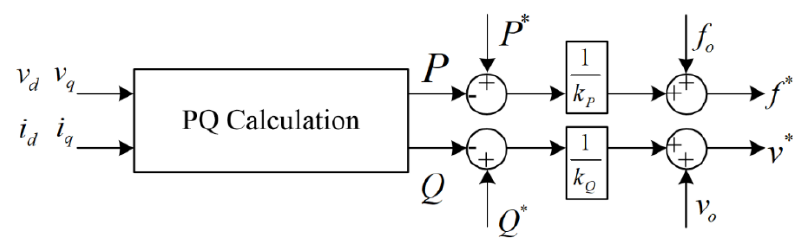
6 of 21 Figure 4. Layout of synchronous reference frame phase-locked loop. 3.3. Droop Implementation The droop controller is implemented to identify the change in the measure and ref-